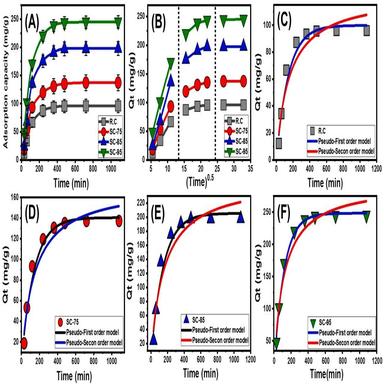
Shows the effect of the time intervals on the on the adsorption of MPn by R.C, SC-75, Sc-85, and SC-95 (A), the Intra-particle diffusion curves of the MPn adsorption processes (B), fitting of the MPn adsorption results by R.C with the kinetic models (C), fitting of the MPn adsorption results by SC-75 with the kinetic models (D), fitting of the MPn adsorption results by SC-85 with the kinetic models (E), and fitting of the MPn adsorption results by SC-95 with the kinetic models (F).